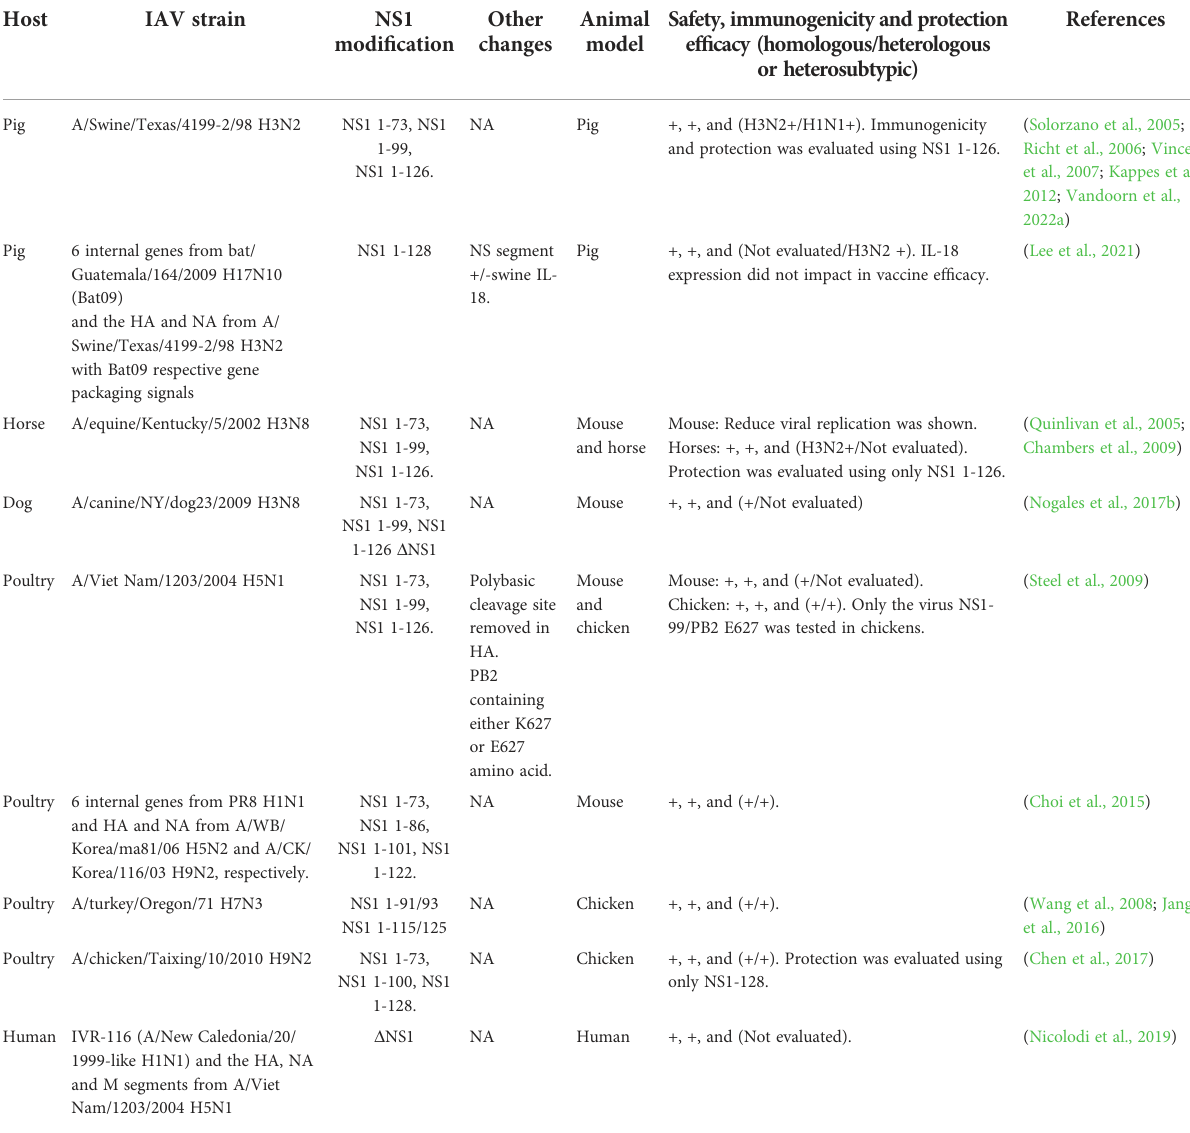
TABLE 1 NS1 truncated or de fi cient viruses used as LAIV.